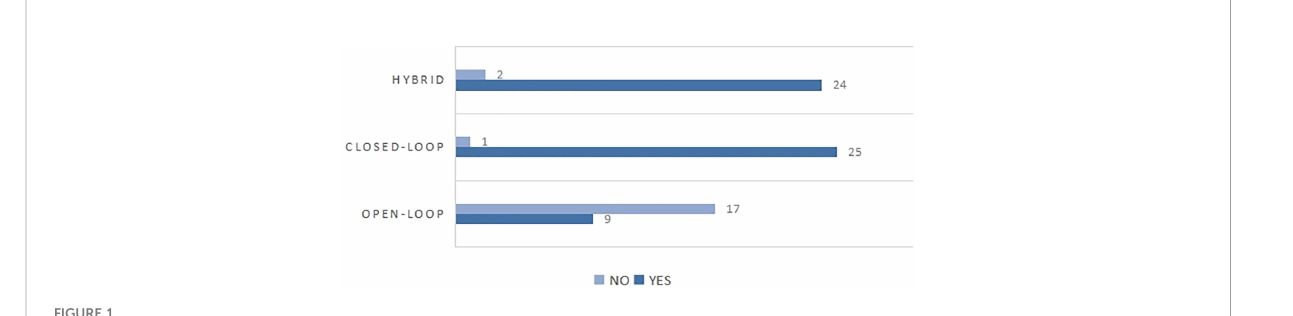
FIGURE 1 Proportion of Scrubbers of three different types for the countries in Table